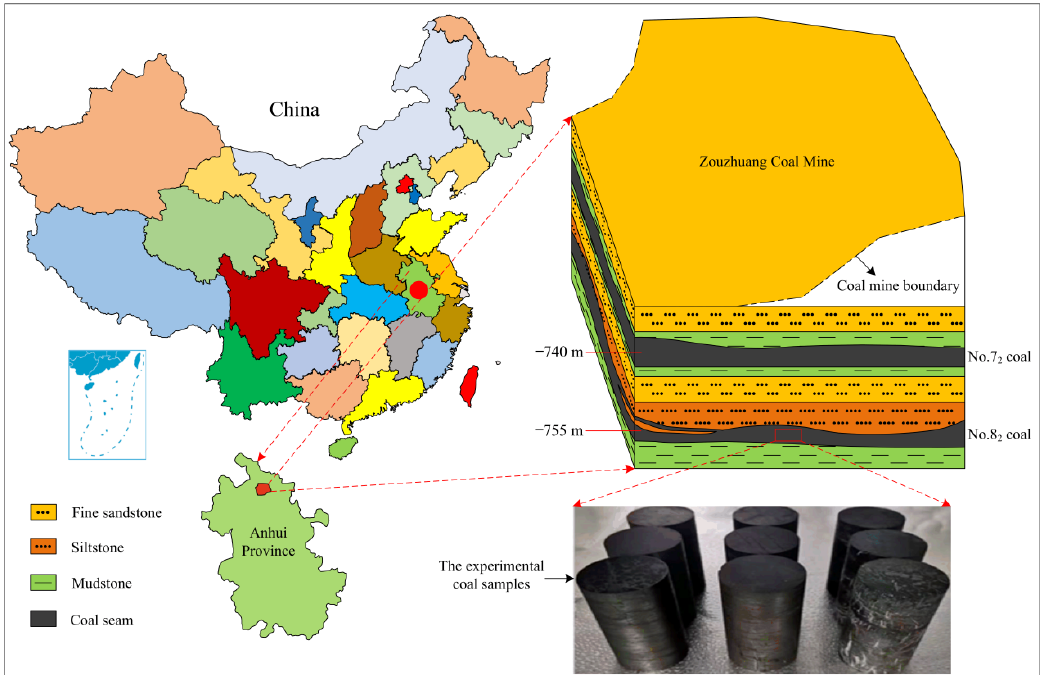
Figure 1. Geographical location and sampling site of the 7 2 and 8 2 coal seams in Zouzhuang Coal Mine.